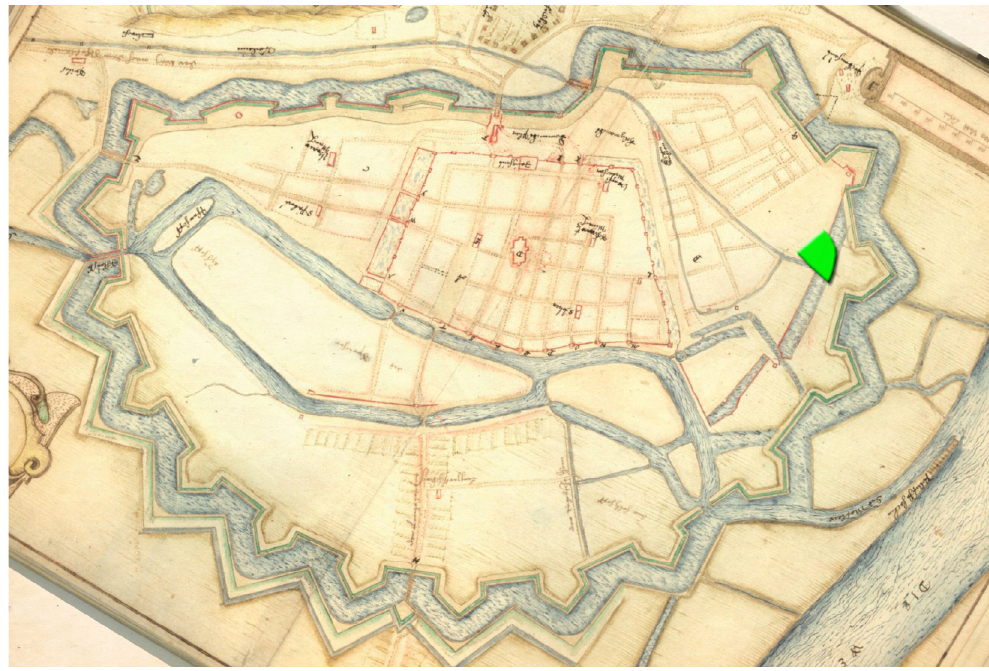
Figure 2. Map of the Gdańsk Fortress around 1635 with the indication of the site No. 255. (http://gdansk.fotopolska.